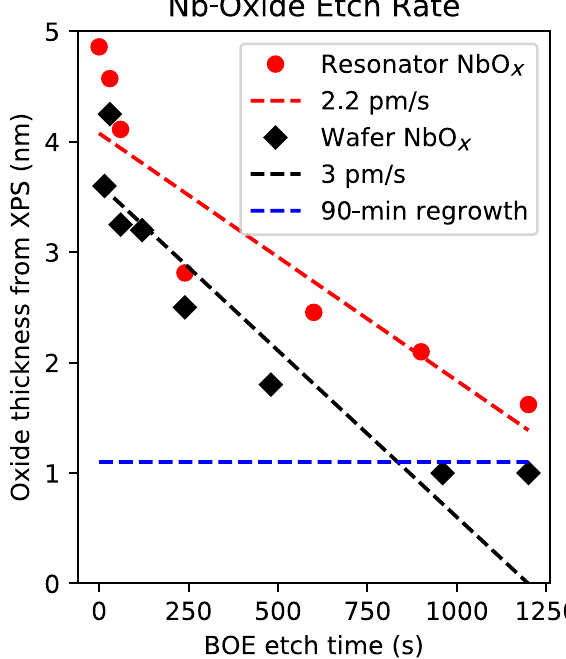
FIG. 14. The NbO x etch rate in 5:1 BOE from XPS measure- ments. The resonator experiments discussed in the main text are plotted in red and the data from Fig. 13 in black. The thick- ness variations at very short etch times reflect sample-to-sample differences in the initial oxide thickness. The resonator process oxide (red) is somewhat thicker than the process oxide simulated by plasma ashing